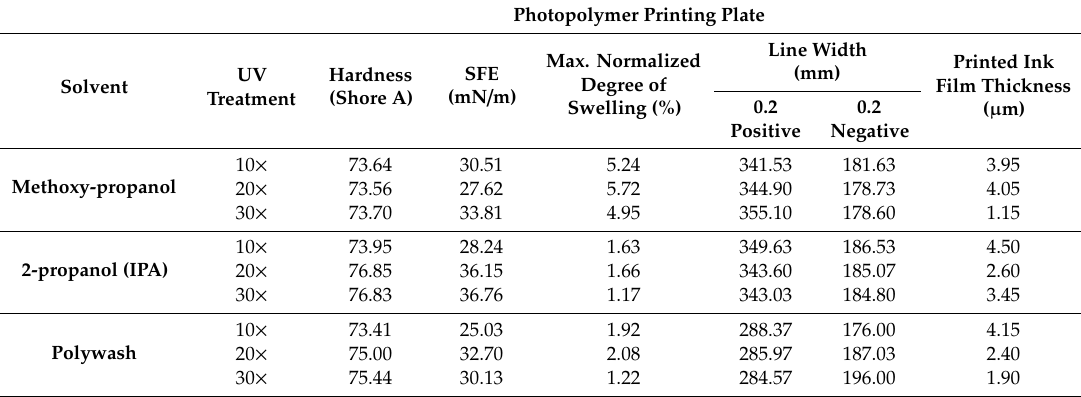
Table 2. Summary of results obtained with photopolymer printing